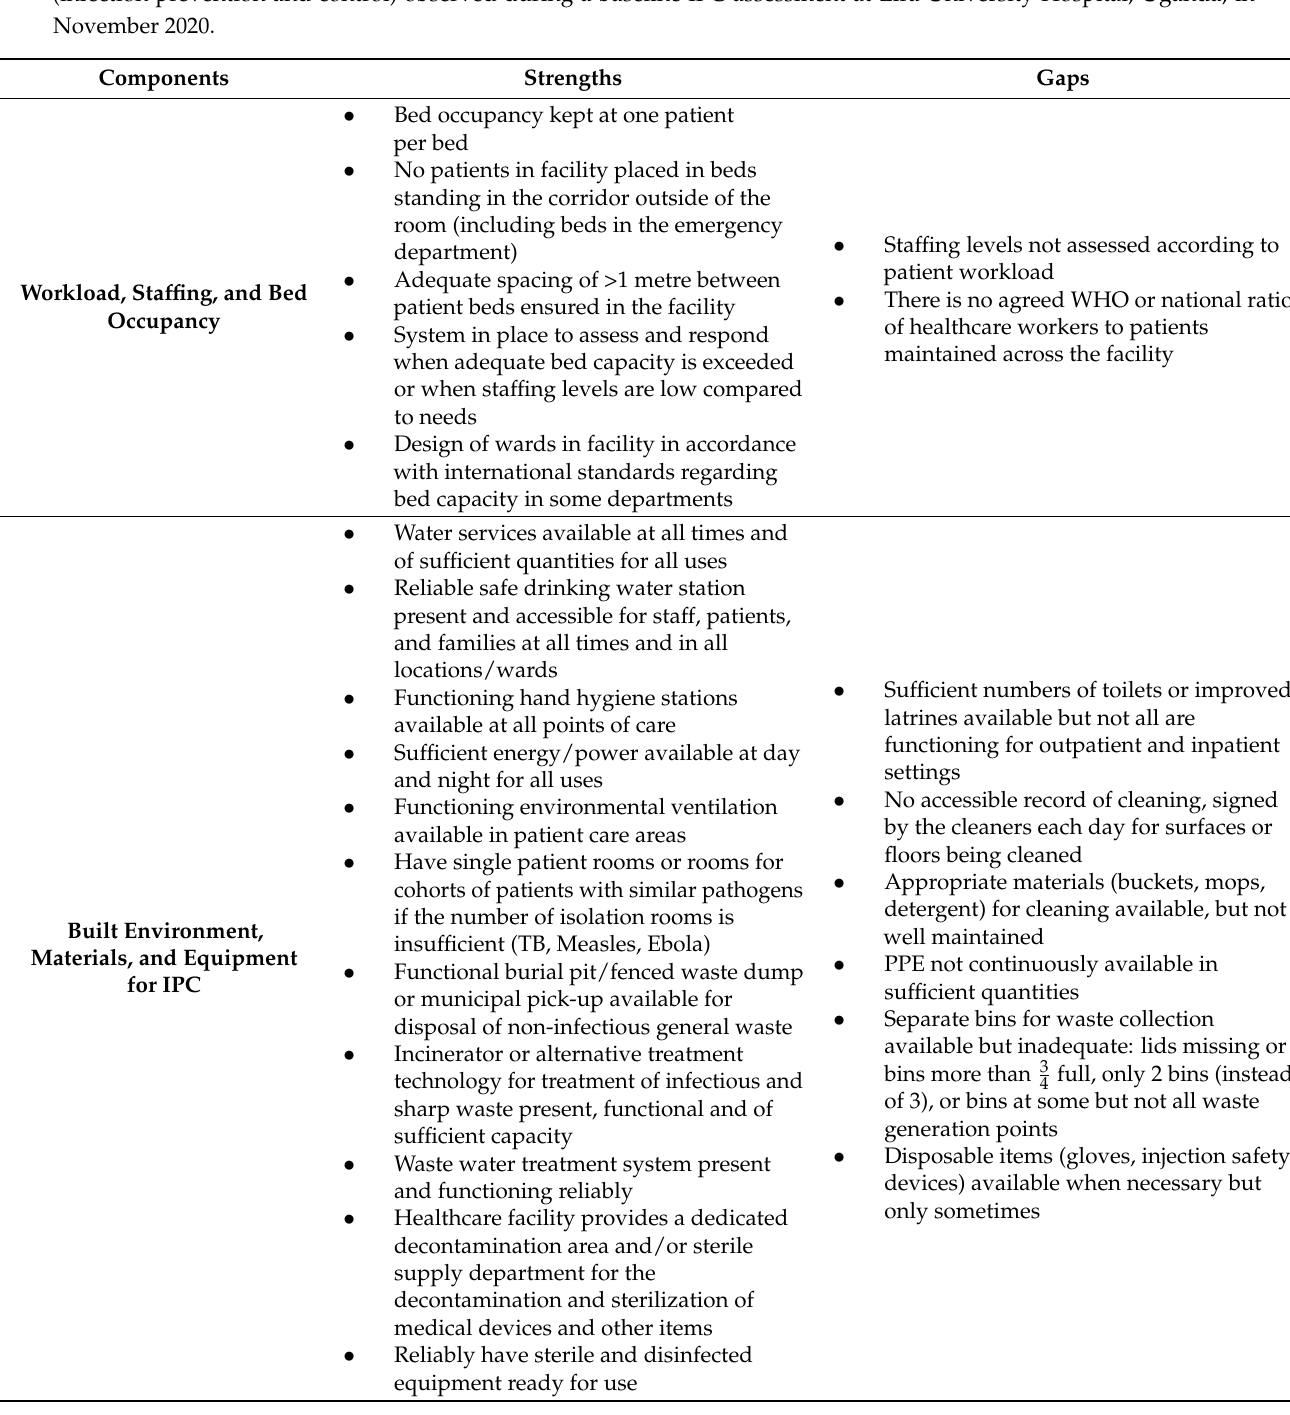
Table 5. Strengths and gaps in workload, staffing, bed occupancy, built environment, materials, and equipment for IPC (infection prevention and control) observed during a baseline IPC assessment at Lira University Hospital, Uganda,